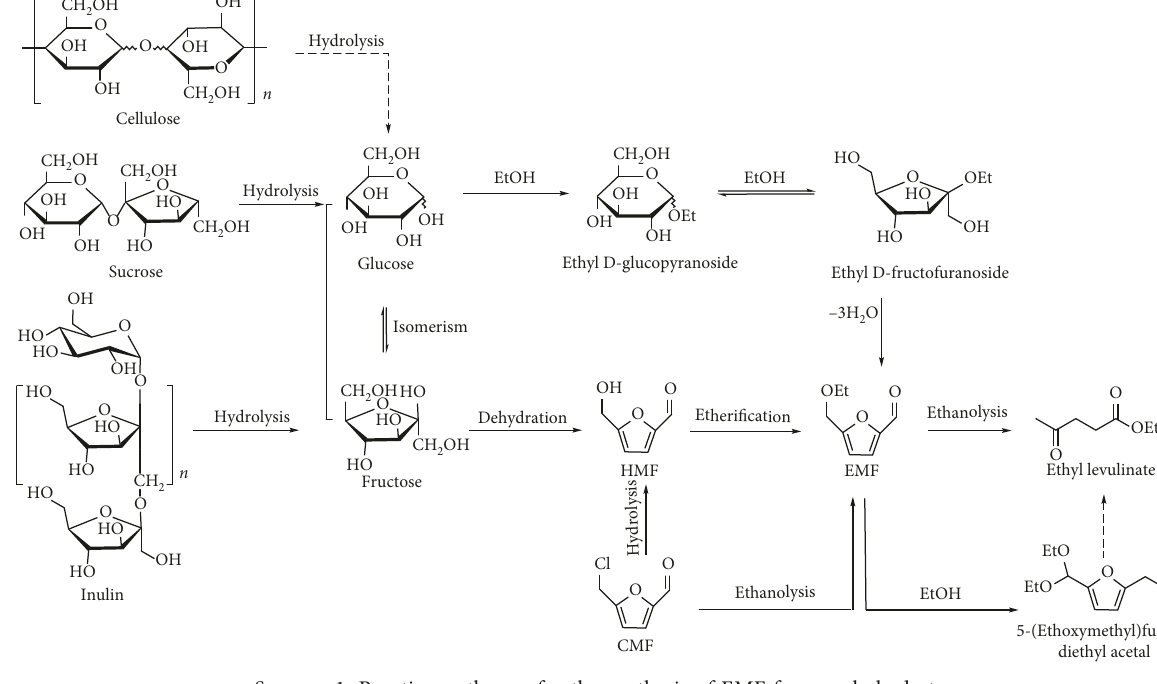
Scheme 1: Reaction pathways for the synthesis of EMF from carbohydrates.